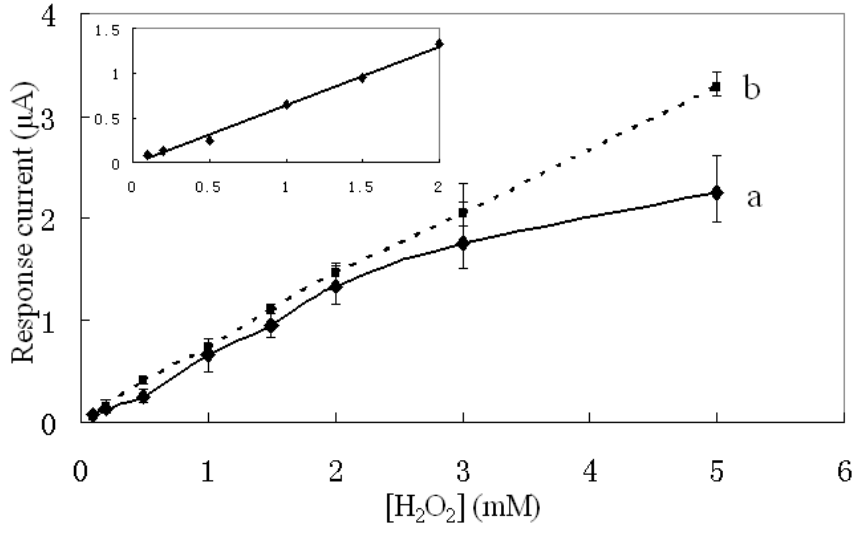
Figure 8. Calibration curve of H O biosensor with HRP immobilized by (a) PPy film and 2 2 (b) physical adsorption. The inset indicates calibration curve obtained for the linear range. Experimental condition: 1 µ L H O , -300 mV applied 2 2